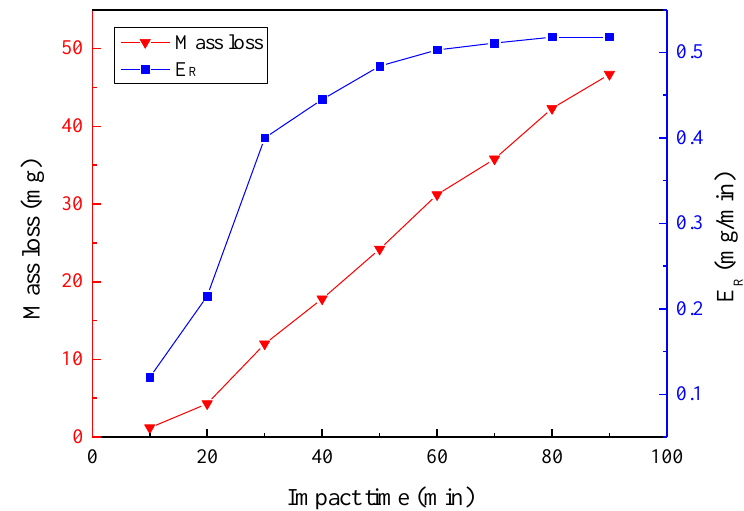
Figure 10. Variation of mass loss and mass loss rate with impact time.